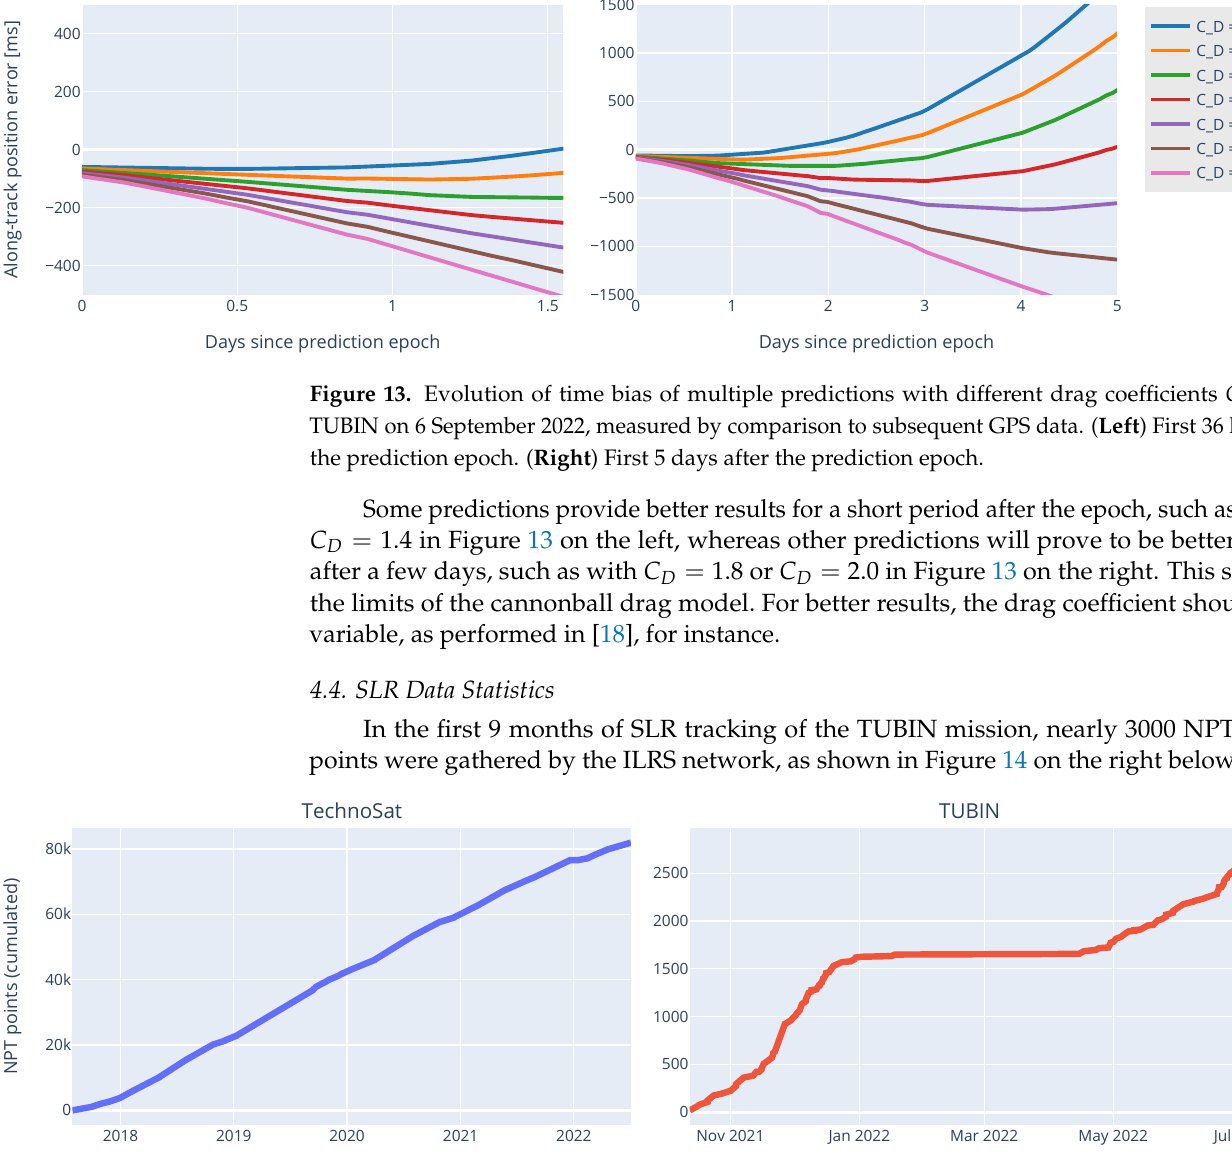
Figure 14. Cumulated number of normal points since the beginning of mission until 4 July 2022 for TechnoSat ( left ) and TUBIN ( right